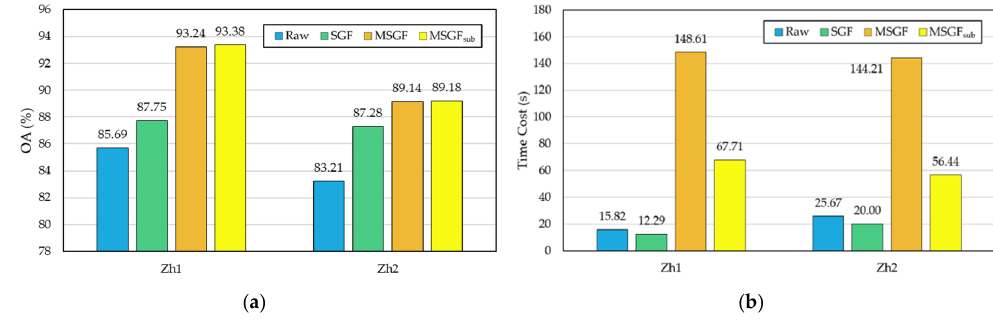
Figure 13. Analysis of the impact of different steps in the proposed FS-MSGF method on: ( a ) OA values and ( b ) computational efficiency.